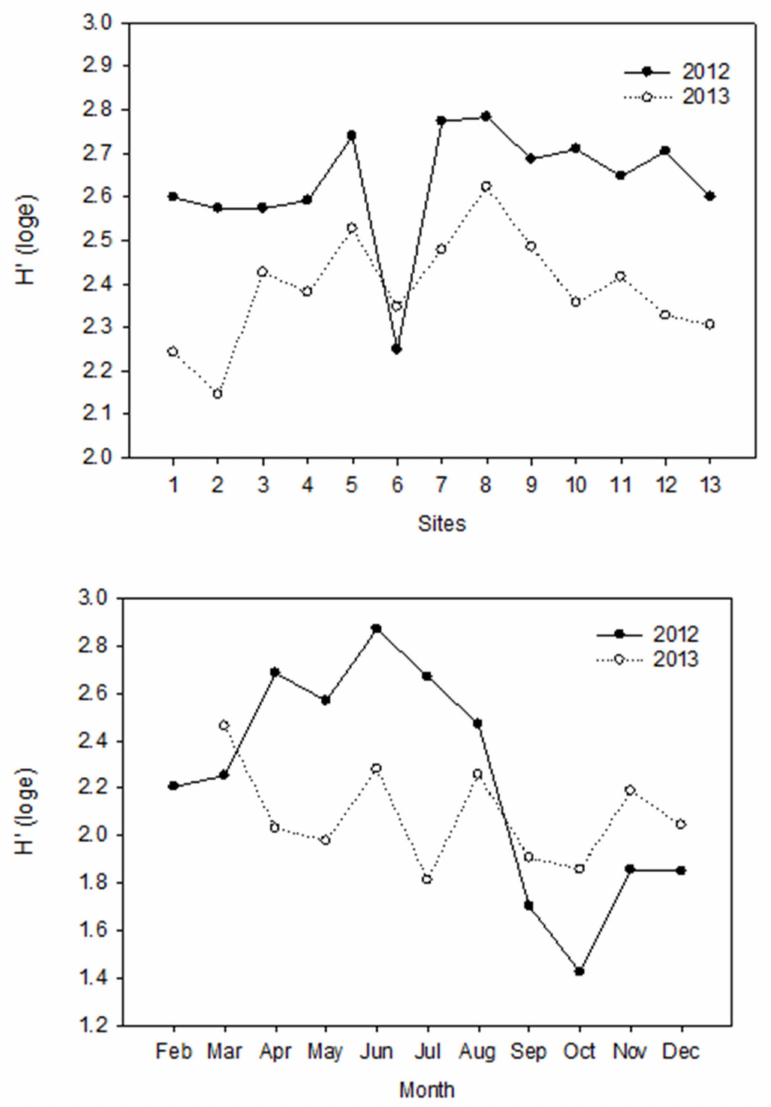
Figure 10. Spatial ( top ) and seasonal ( bottom ) patterns in Shannon–Wiener diversity index of mesozooplankton in the MCBs in 2012 and 2013 from winter to